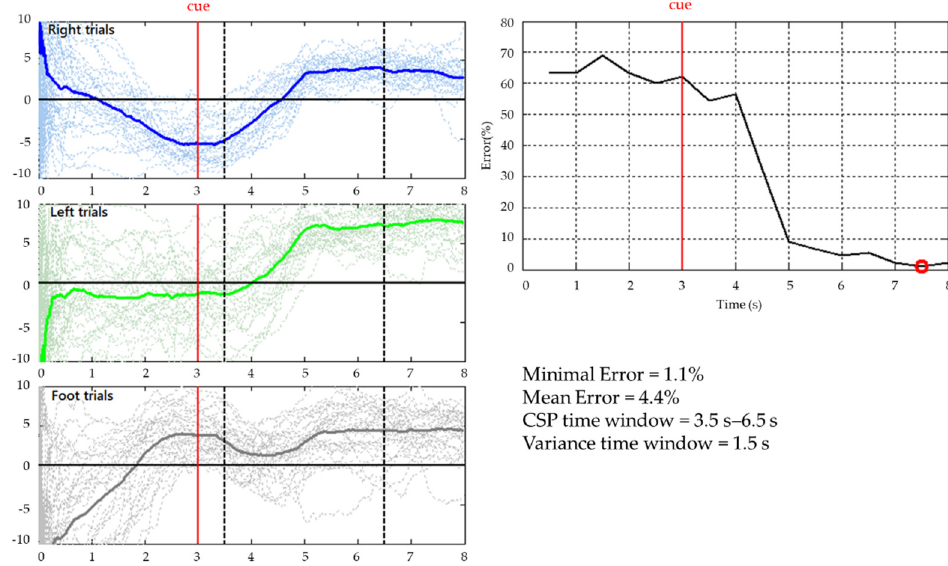
Figure 8. Classification results for subject 1. Left–side plots: LDA classification output for right, left, and foot imagination tasks; right–side plot: Online classification error rate.